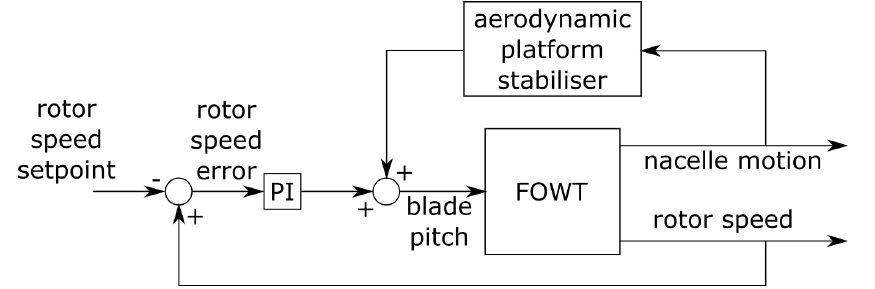
Figure 4. Conventional blade-pitch PI control loop and aerodynamic platform stabiliser